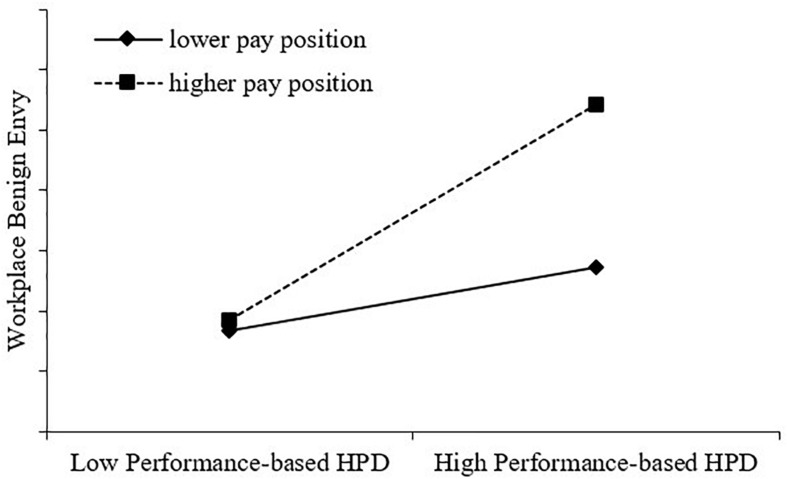
Moderation by pay position.